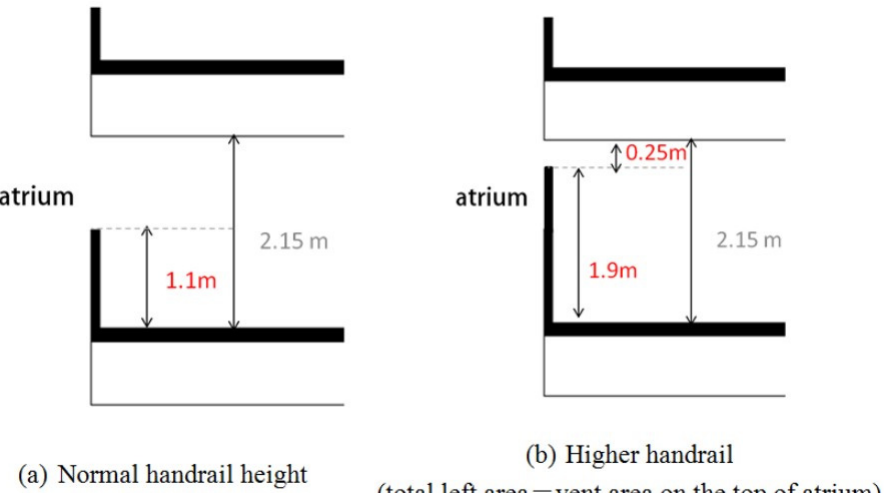
Figure 7. Handrail height settings.